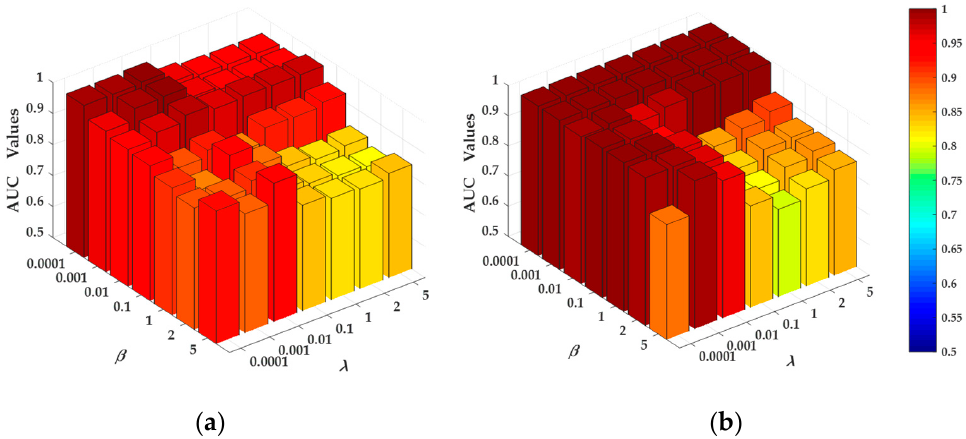
Figure 8. Effect of parameter R over AUC values on experimental datasets.